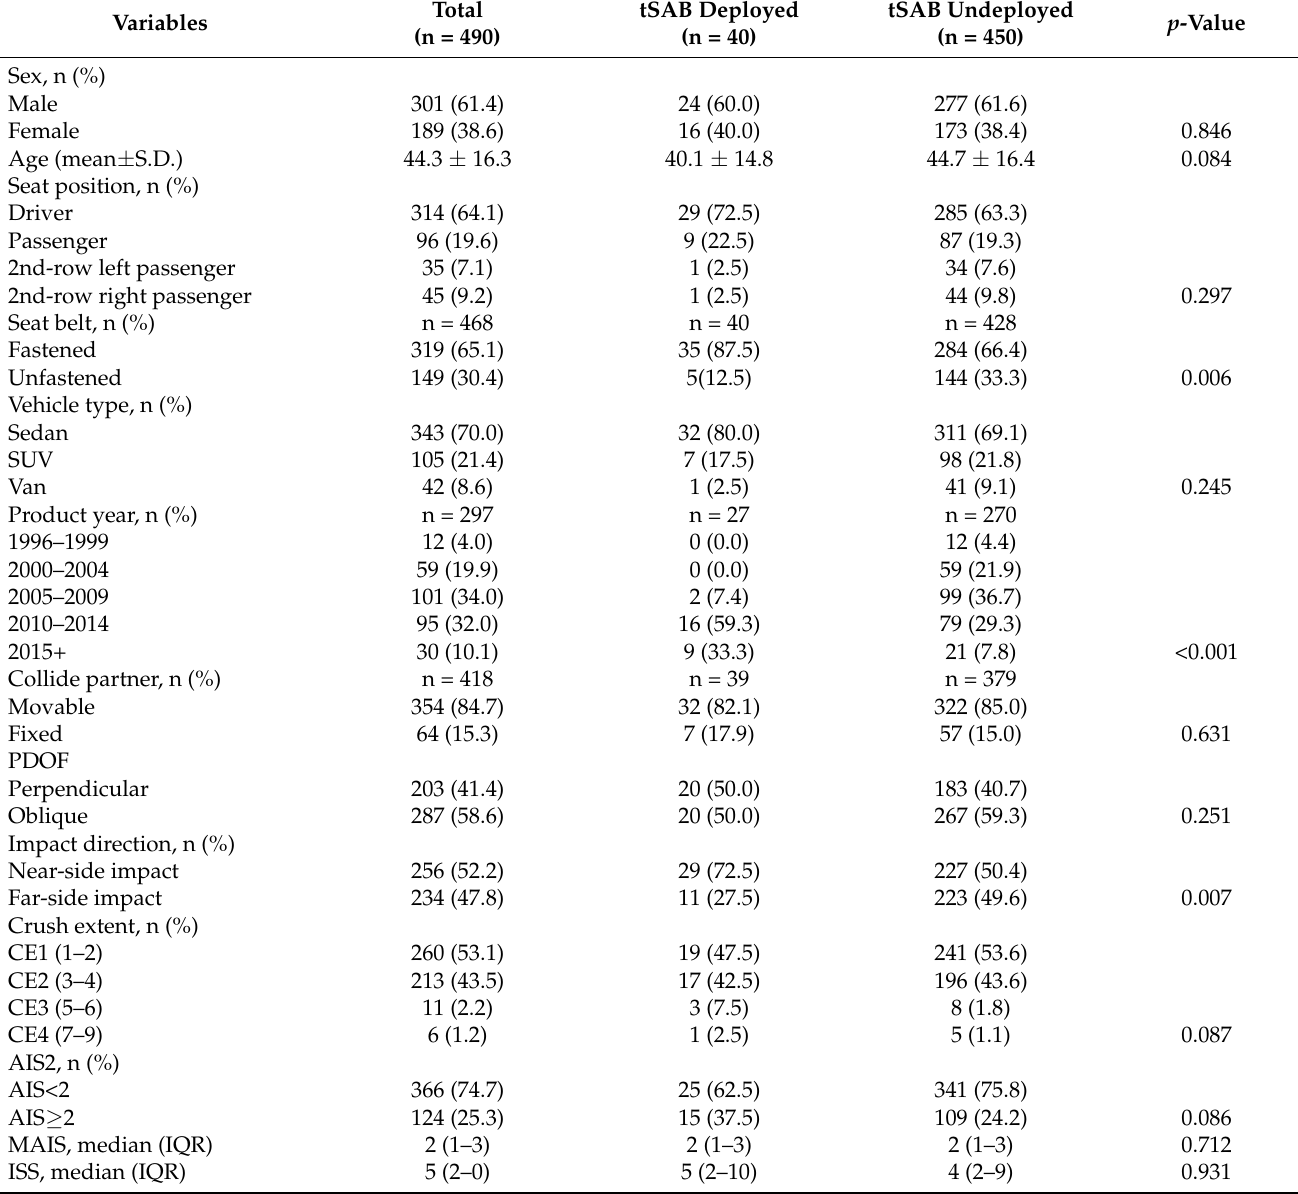
Table 1. Comparison of demographic characteristics according to thoracic side airbag